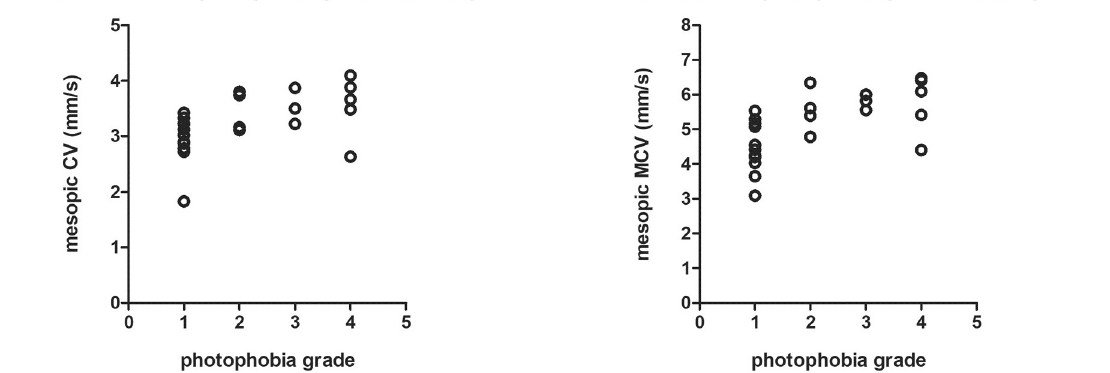
Fig 1. Scatter graphs illustrating the correlations between photophobia grade and both mesopic constriction velocity (CV) and maximum constriction velocity (MCV) in patients with benign essential blepharospasm.